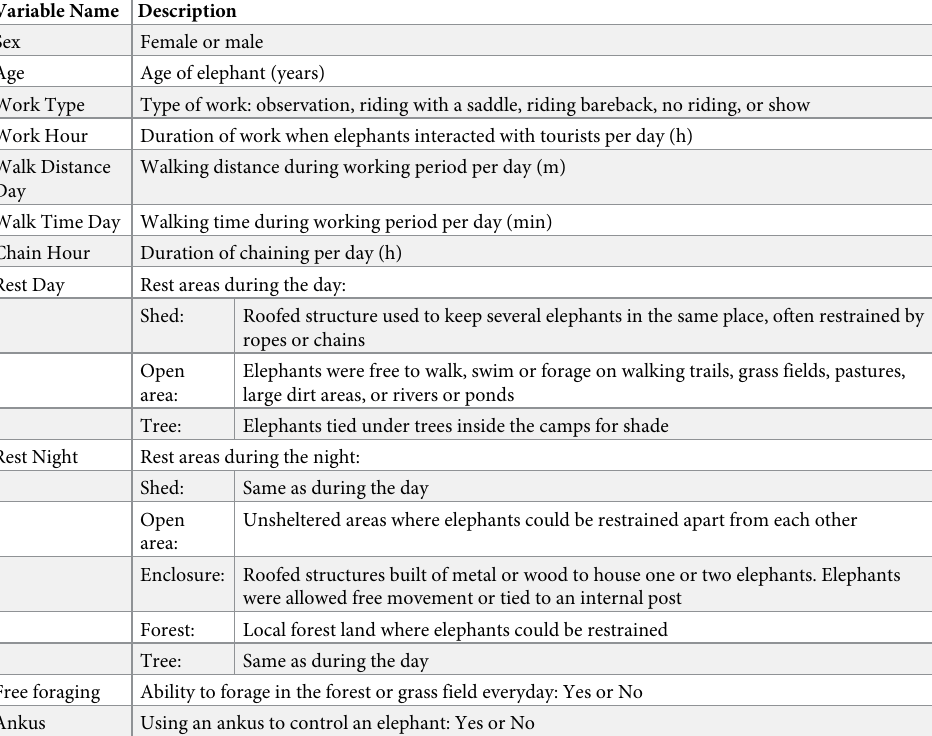
Table 2. Description of demographic and management variables used in the GEE